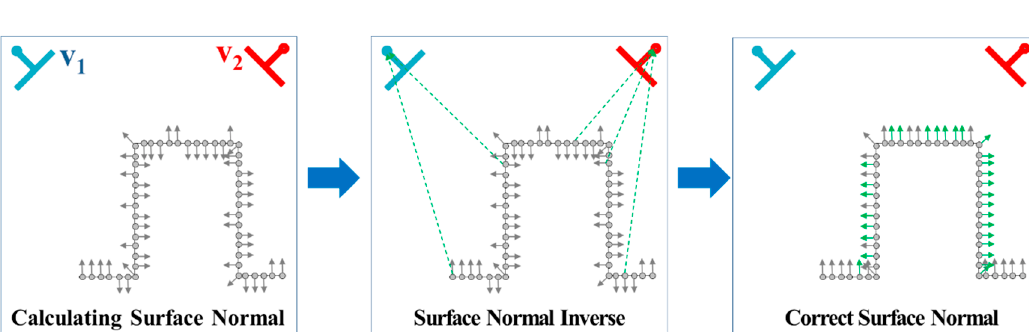
Figure 3. Adjusting the surface normal based on the geometry condition with a sensor position vector.